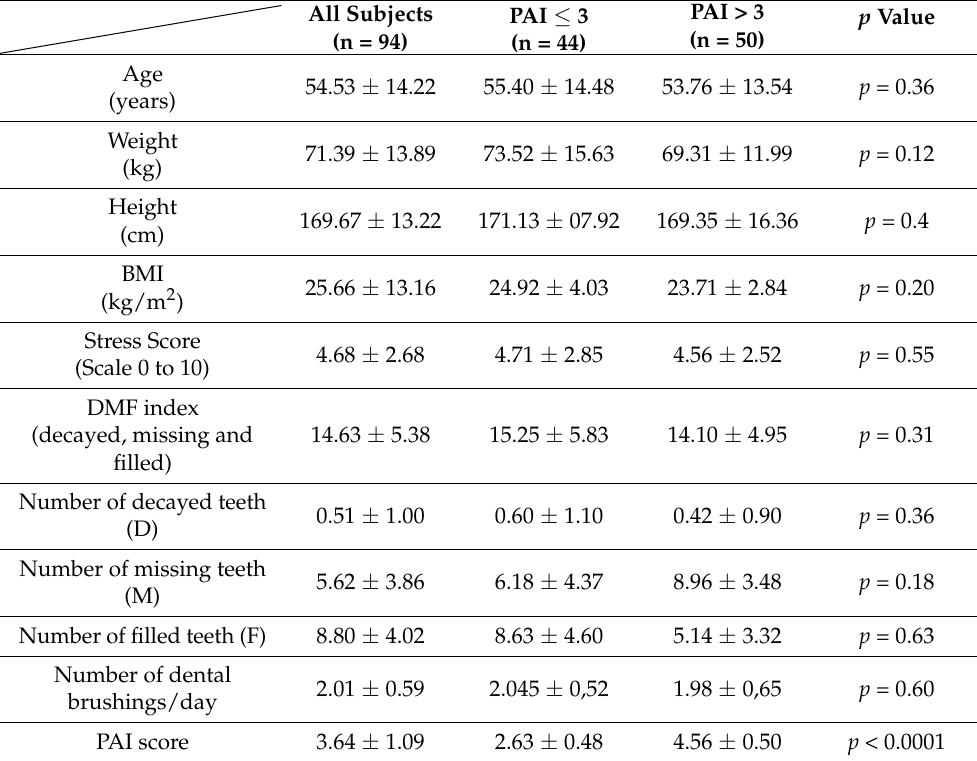
Table 1. Clinical and oral parameters based on the periapical index score (data as mean ± SD. Unpaired Mann–Whitney